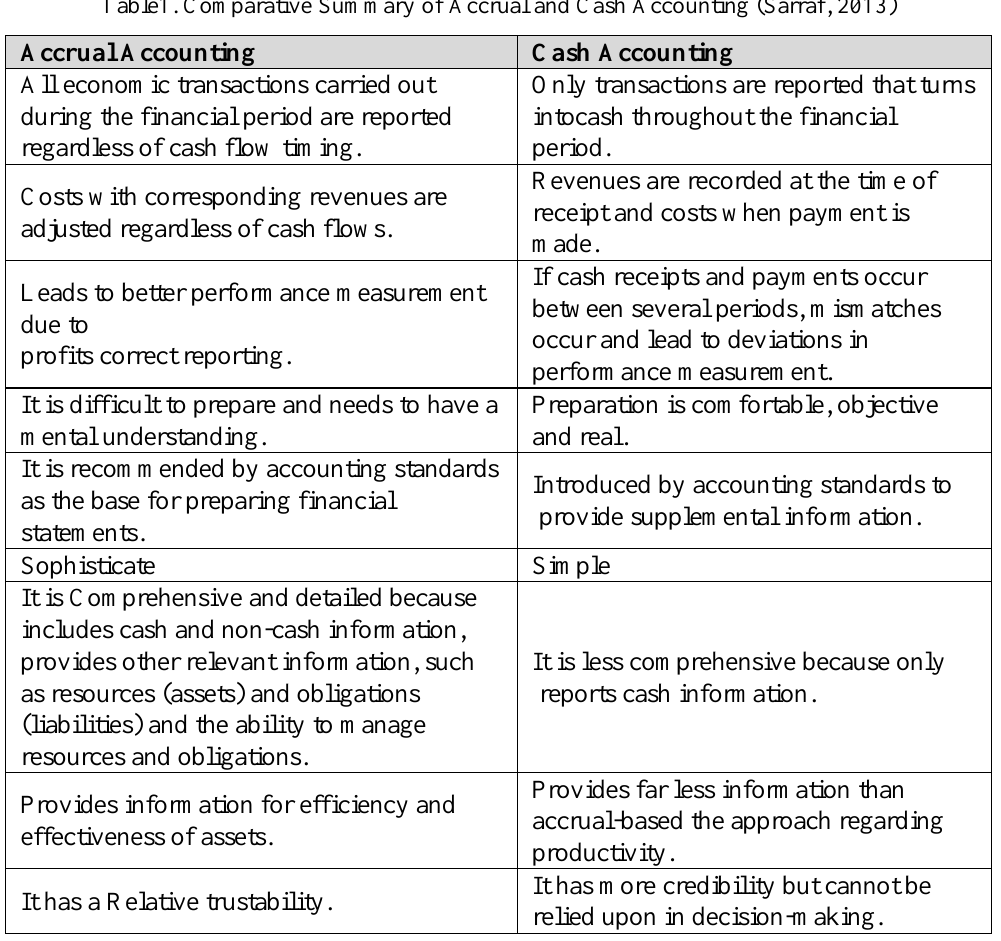
Table1. Comparative Summary of Accrual and Cash Accounting (Sarraf,